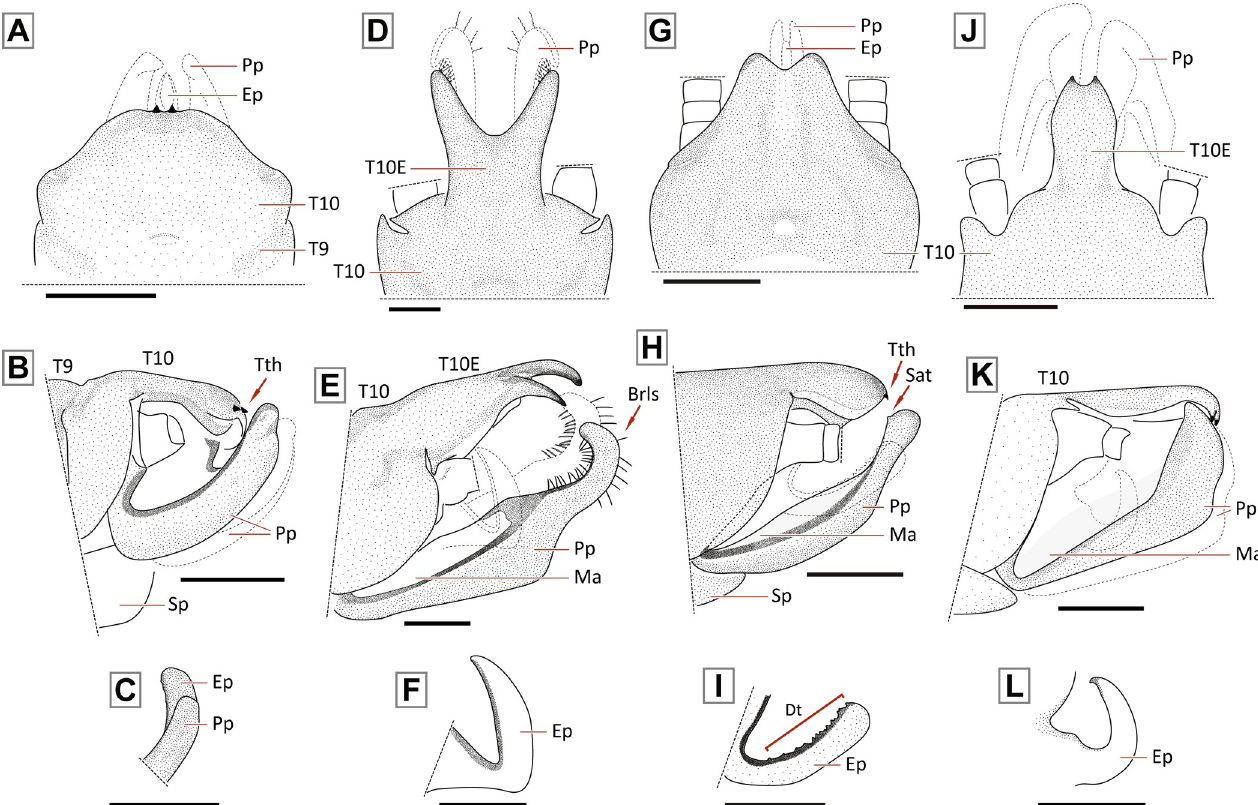
Fig 9. Male terminalia of the Paragripopteryx species. Paragripopteryx intervalensis : (A , B) male specimen from Serra Furada, Santa Catarina state, terminalia in dorsal and lateral views, respectively. Paragripopteryx intervalensis : (C) detail of paraproct and epiproct length from species sampled at the Intervales State Park, S ã o Paulo state. Paragripopteryx kapilei : (D) male from Santa Catarina state, terminalia in dorsal view. Paragripopteryx kapilei : (E) paratype male, terminalia in lateral view. Paragripopteryx kapilei : (F) detail of male epiproct in lateral view. Paragripopteryx merui : (G , H) male, terminalia in dorsal and lateral views, respectively. Paragripopteryx merui : (I) detail of male epiproct in lateral view. Paragripopteryx paranapiacabae : (J , K) holotype and paratype adult male, terminalia in dorsal and lateral views, respectively. Paragripopteryx paranapiacabae : (L) detail of male epiproct in lateral view (Scale bar: 0.2